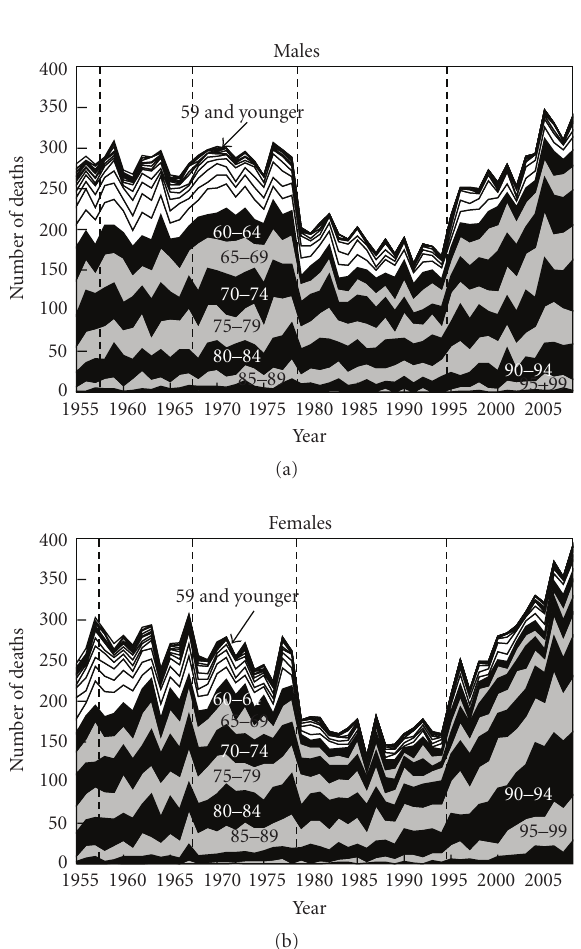
Figure 5: Annual trends in the number of deaths from NMSC by sex and age group in Japan (1955 ∼ 2008), modified from Ohtsuka and Nagamatsu